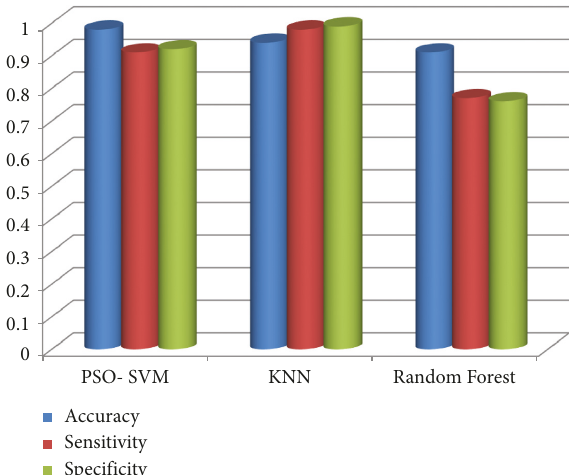
Figure 3: Classifiers’ performance with feature selection and feature